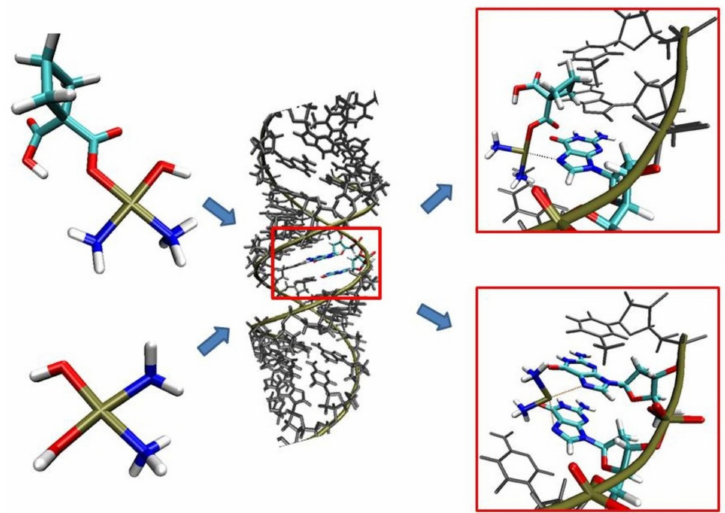
Figure 1. Formation of adducts between DNA and